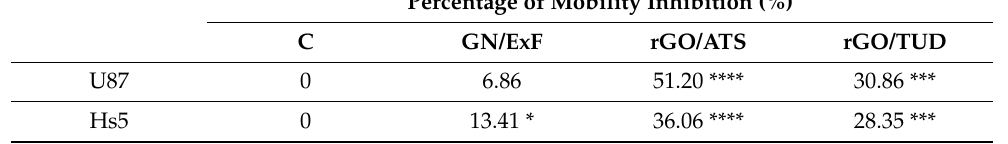
Table 3. Analysis of U87 and Hs5 cell motility inhibition in co-culture treated with graphene (GN) and reduced graphene oxide (rGO) expressed in percentage of mobility inhibition (%). Statistical significance between the control and the treated cells is indicated by an asterisk and was assessed using Bonferroni’s multiple comparisons test. Differences with p < 0.05 were considered statistically significant. One asterisk (*) indicates p < 0.05, three asterisk (***) indicates p < 0.001 and four asterisks (****) indicate p <